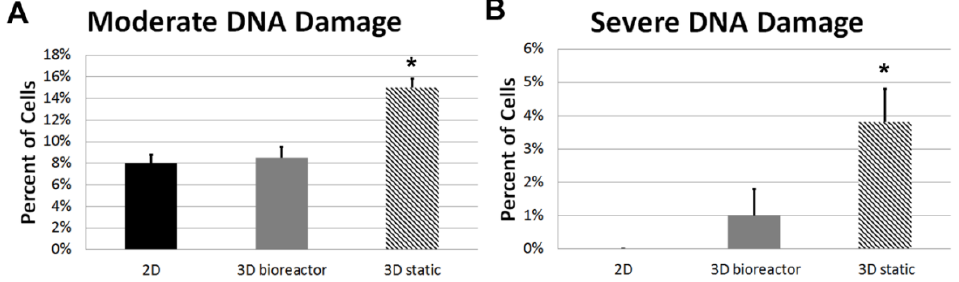
Figure 8. Comet Assay for DNA Damage: Graphs showing the percent of cells with ( A ) moderate and ( B ) severe DNA damage (* indicates p <